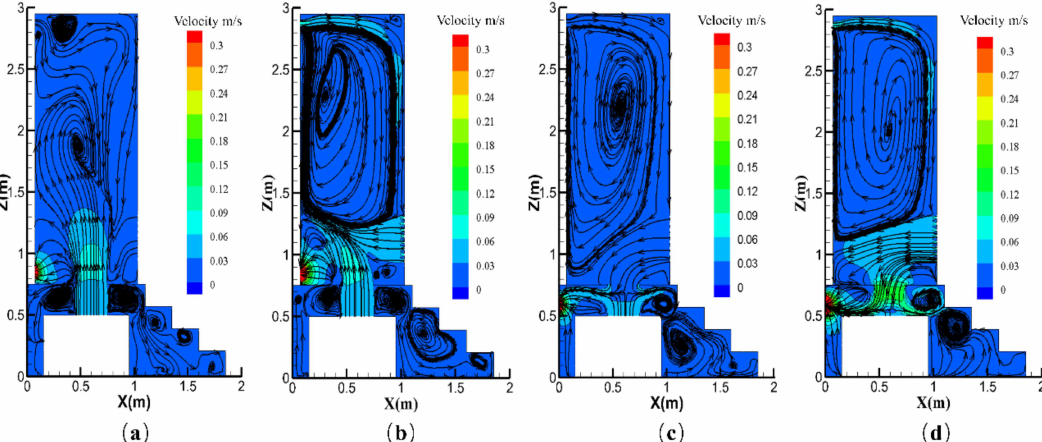
Figure 7. Streamline contours under different ACH (unit: h − 1 ) values for Cases 1 and 2. Case 1: ( a ) ACH = 5, ( b ) ACH = 10; Case 2: ( c ) ACH = 5, ( d ) ACH = 10.